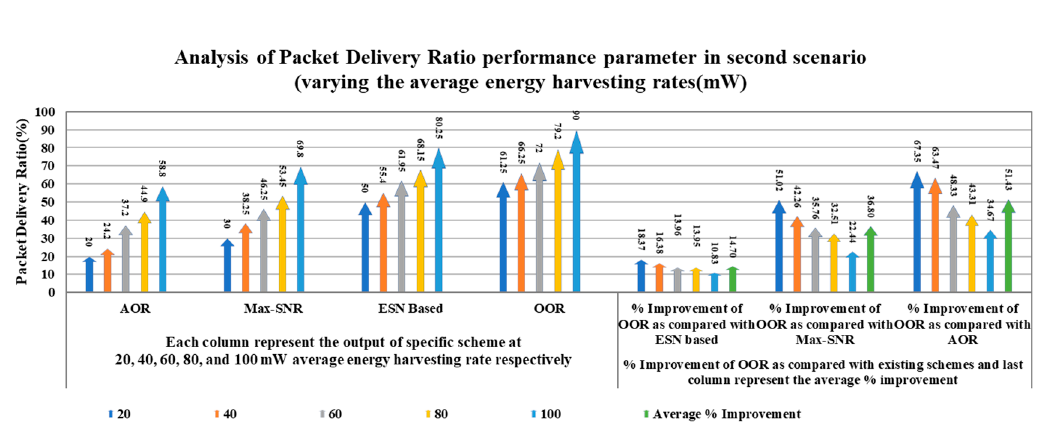
Figure 13. Detailed performance reflection of OOR with packet delivery ratio parameter (second scenario).